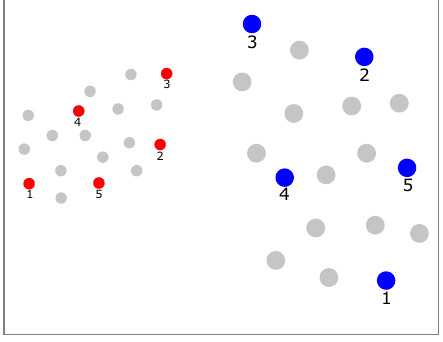
Figure 9. Illustration of the corresponding point selection.